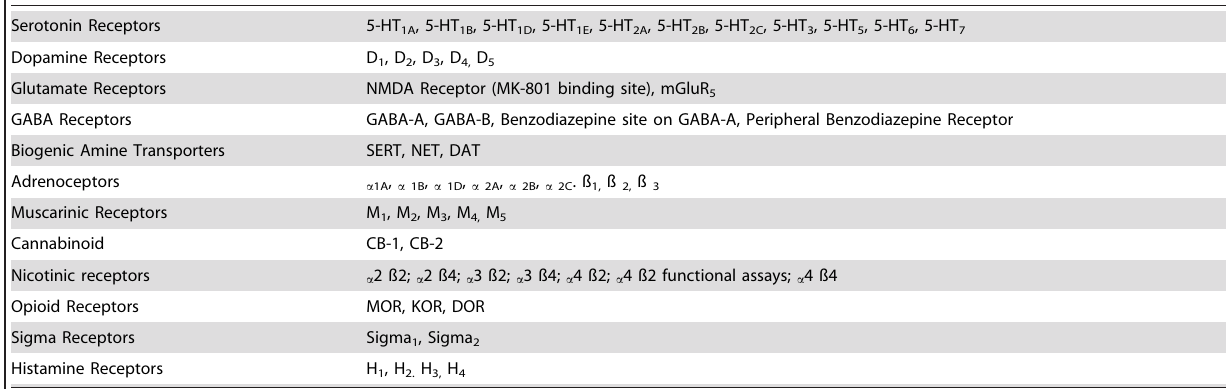
Serotonin Receptors